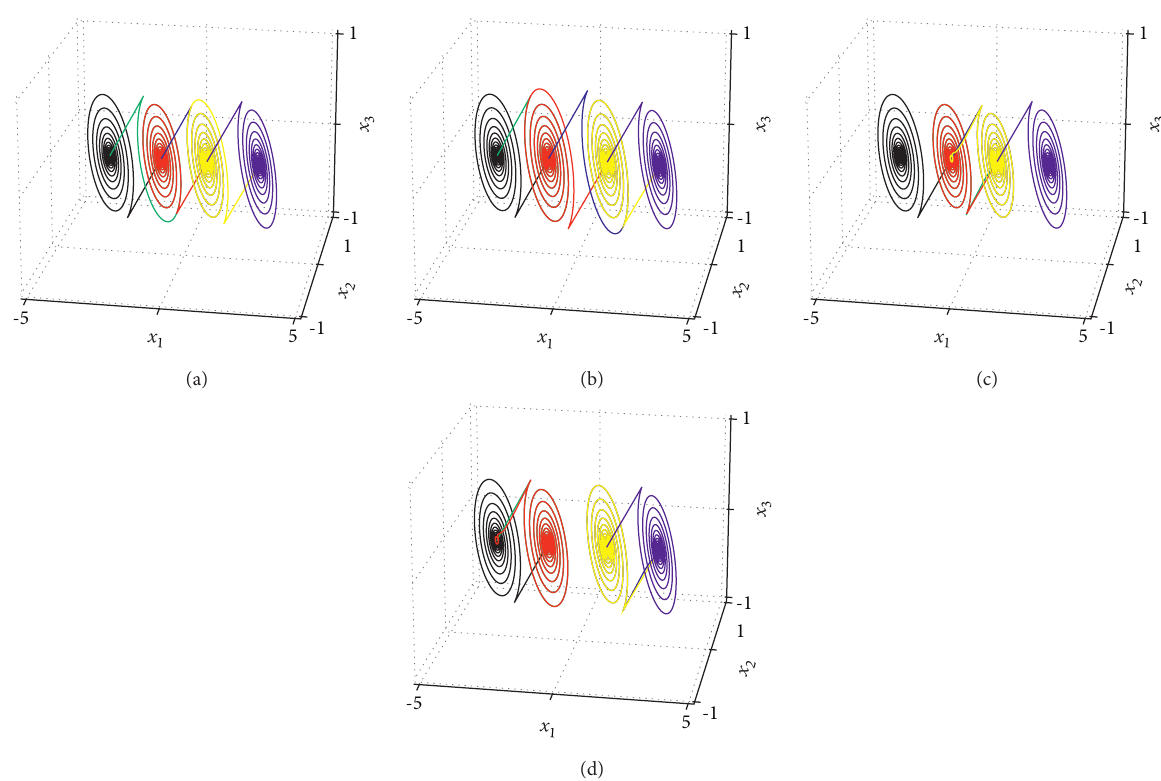
� α ( 1 − e − a τ cos ( b τ )) + . 00001, and (b) c � ( α ( e − a τ cos ( b τ ) − 1 ) / e − a τ cos ( b τ )) 1 2 � α ( 1 − e − a τ cos ( b τ )) , and (d) c � ( α ( e − a τ cos ( b τ ) − 1 ) / e − a τ cos ( b τ )) L U